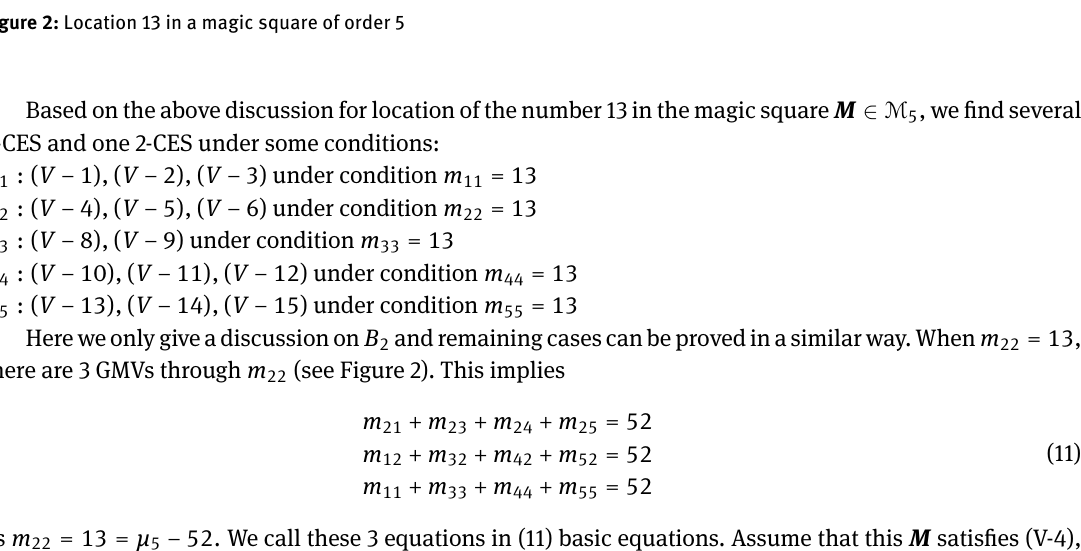
Figure 2: Location 13 in a magic square of order